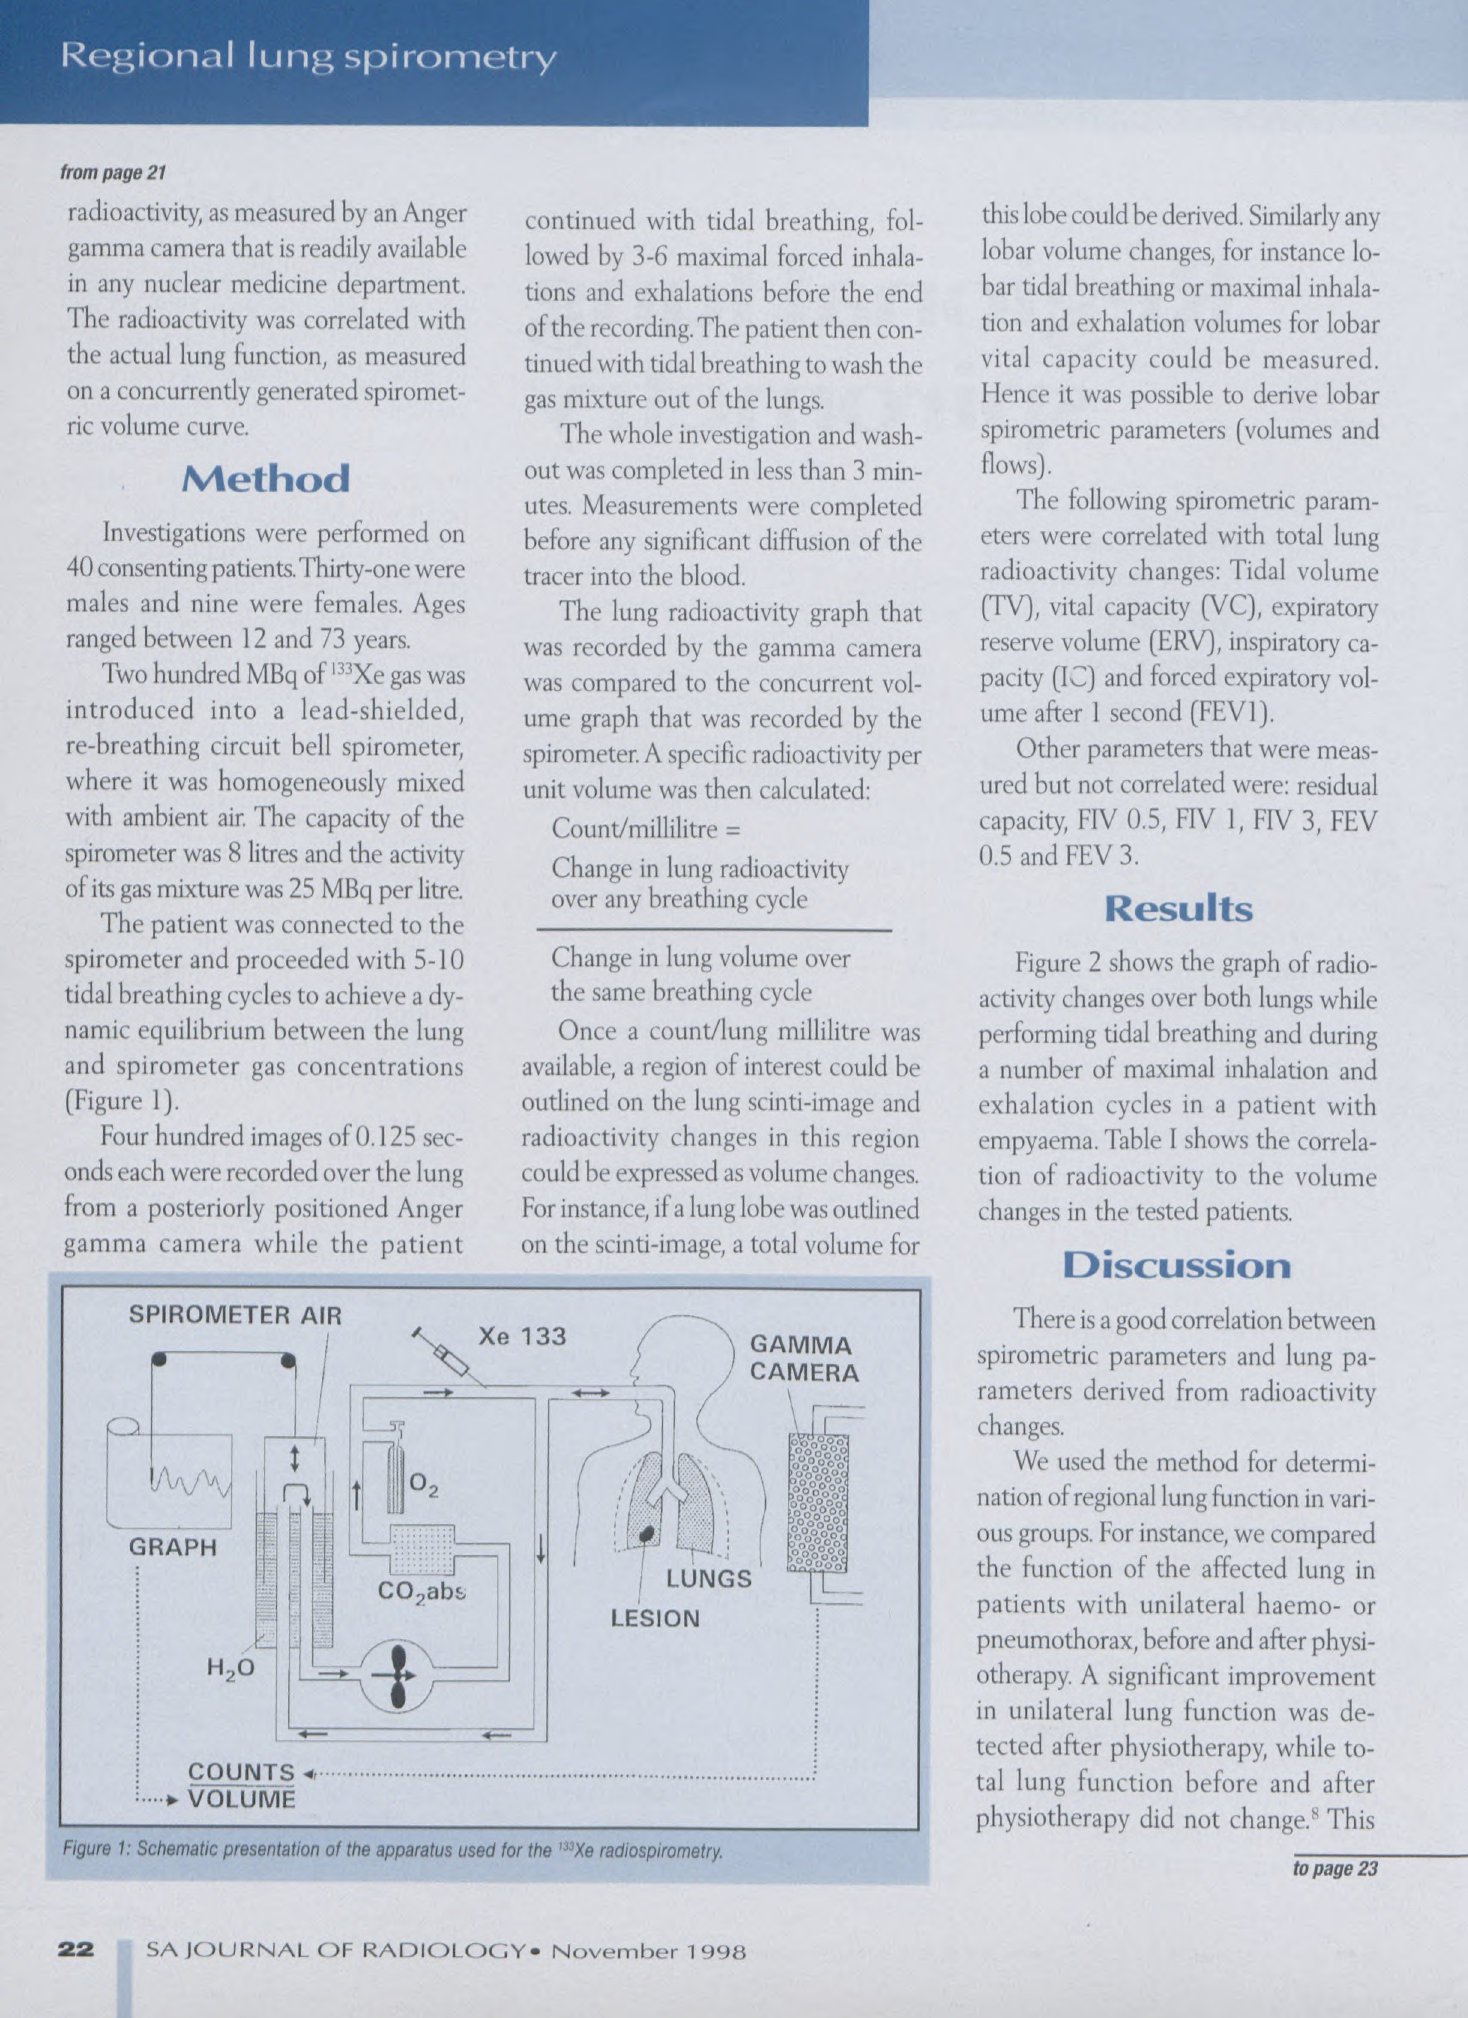
Figure 1: Schematic presentation of the apparatus used for the r33Xe